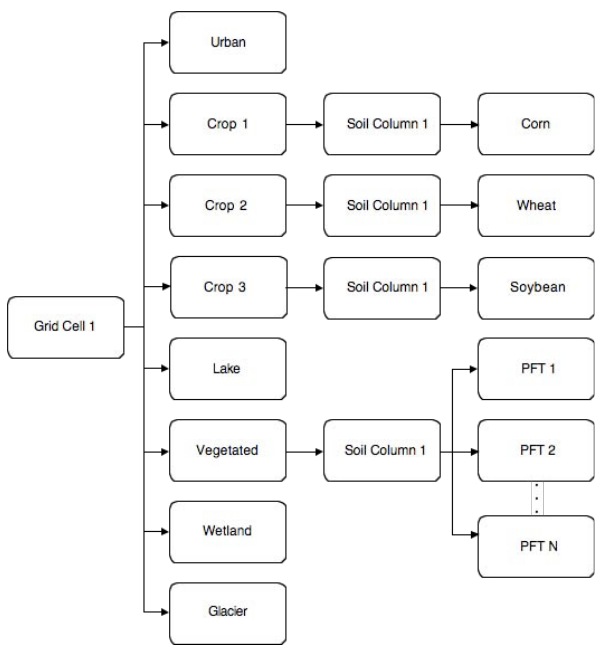
Fig. 1. An example of the sub-grid hierarchy in CLM-Crop (based on concepts of Oleson et al.,